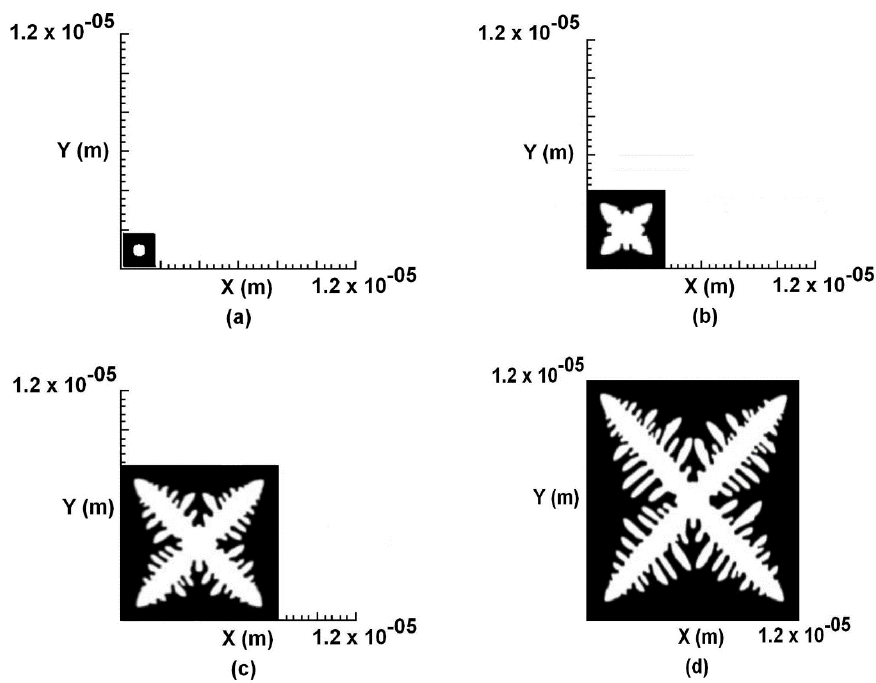
Figure 4. Development of the adaptive computational domain for dendritic growth. The numerical grids and solidification times are: (a) 85×85 points, 4.47×10 − 9 sec; (b) 205×205 points, 3.62×10 − 8 sec; (c) 405×405 points, 9.35×10 − 8 sec; and (d) 605×605 points, 1.50×10 − 7